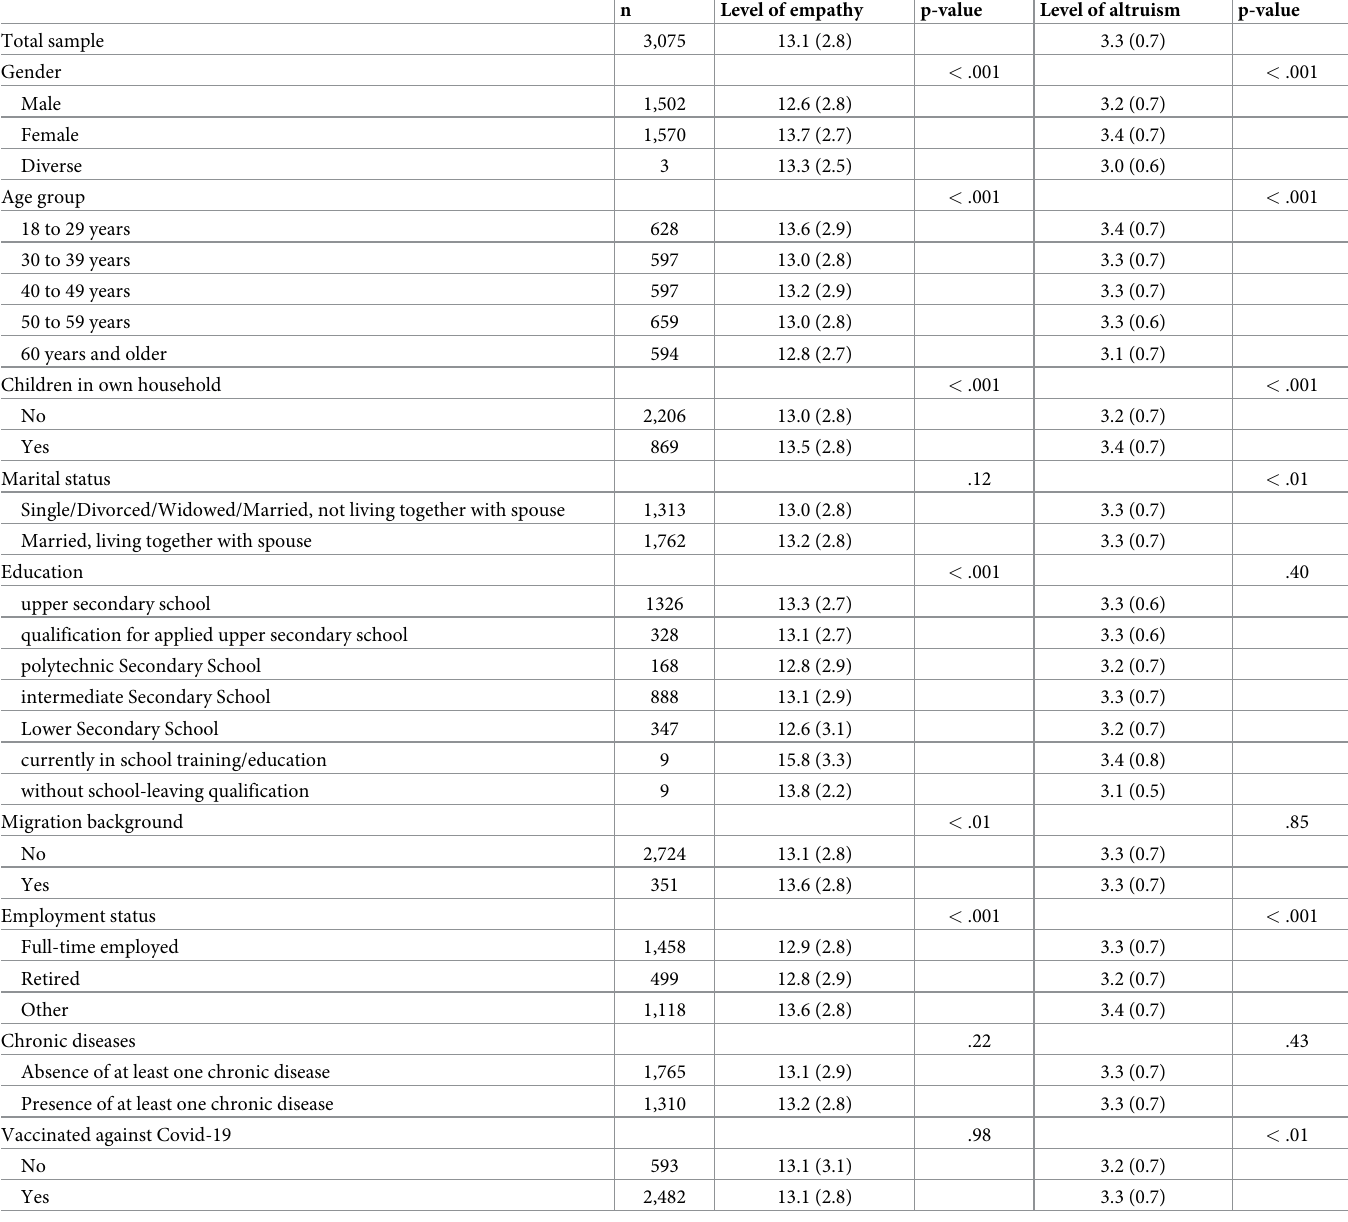
Table 1. Level of empathy and altruism among several